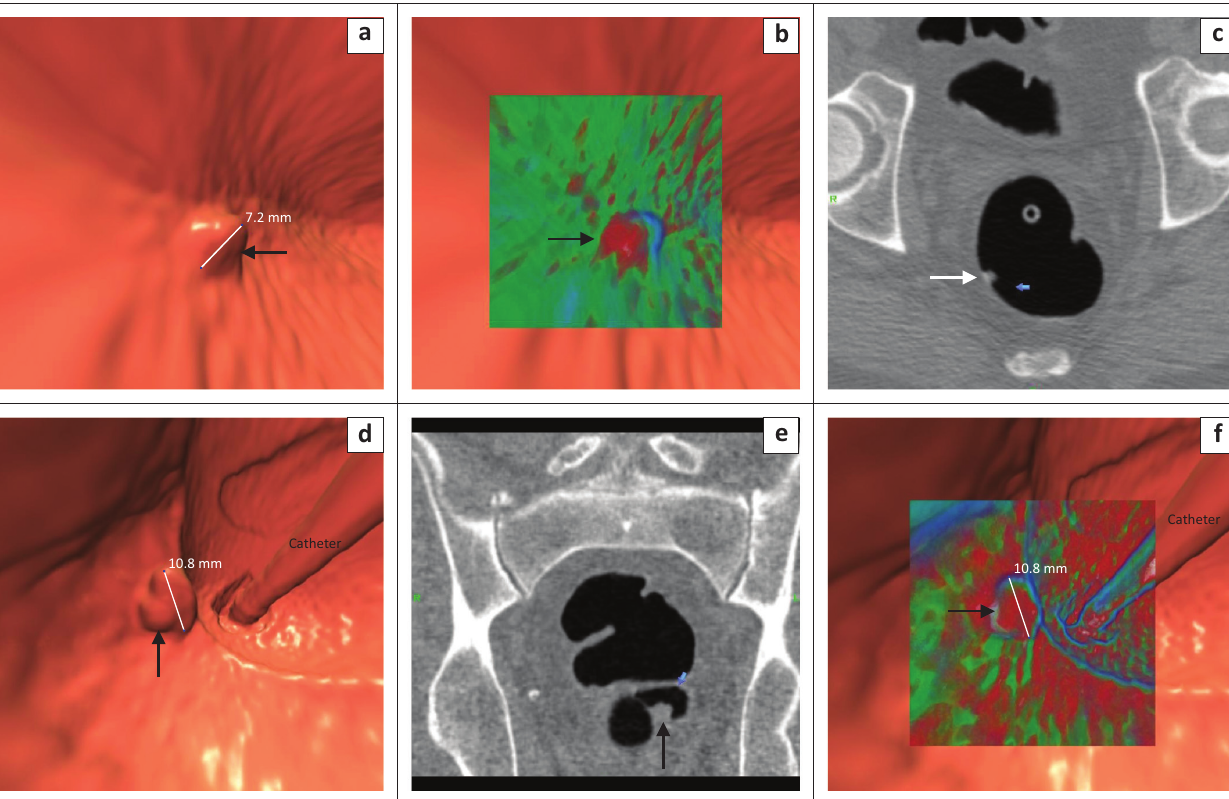
FIGURE 15: (a) 3D view showing 7 mm sessile polyp (black arrow); (b) TD showing predominantly red = soft tissue (black arrow) indicating polyp; (c) 2D axial supine view shows homogenous polypoidal density in keeping with a polyp (white arrow); (d) 3D endoluminal view showing an 11 mm polypoid lesion (black arrow); (e) 2D axial view showing homogenous lesion (black arrow); (f) TD showing predominantly red = soft tissue (black arrow) compatible with an advanced adenoma.